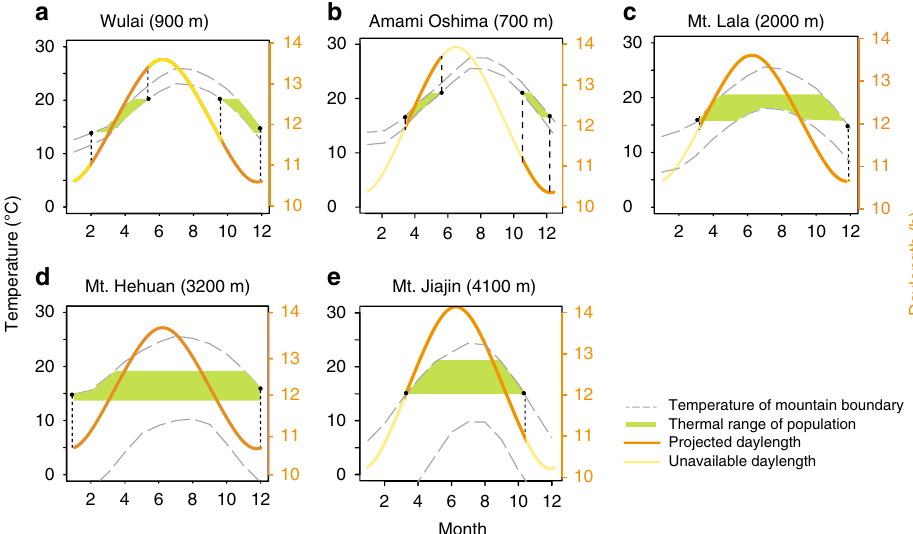
Fig. 4 The temperature and corresponding photoperiod in relation to elevation, month, and daylength for each of the fi ve mountain ranges. The thermal niche space where beetles are present, estimated in Fig. 3, ( fi lled green regions) and the environmental temperature at different elevations (the gray dash line) for the different mountain ranges determine the suitable daylengths (orange lines) and unavailable daylengths (yellow lines) of the beetles occurrence in a Wulai, b Amami Oshima, c Mt. Lala, d Mt. Hehuan, and e Mt. Jiajin. The maximum elevation of each mountain range is given in